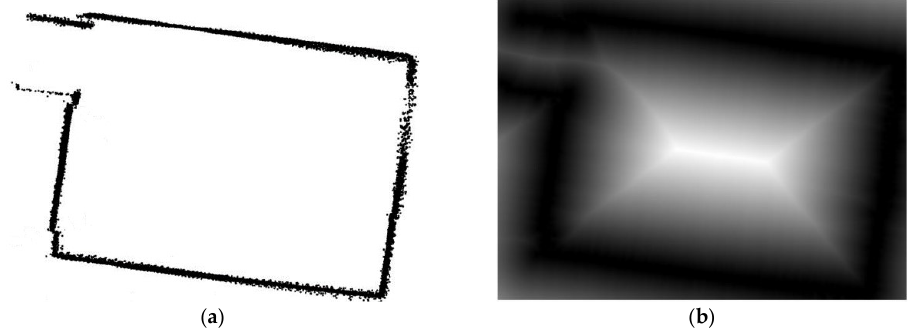
Figure 5. Part of the constructed map I: ( a ) binary representation; and ( b ) the corresponding result using the DT method.